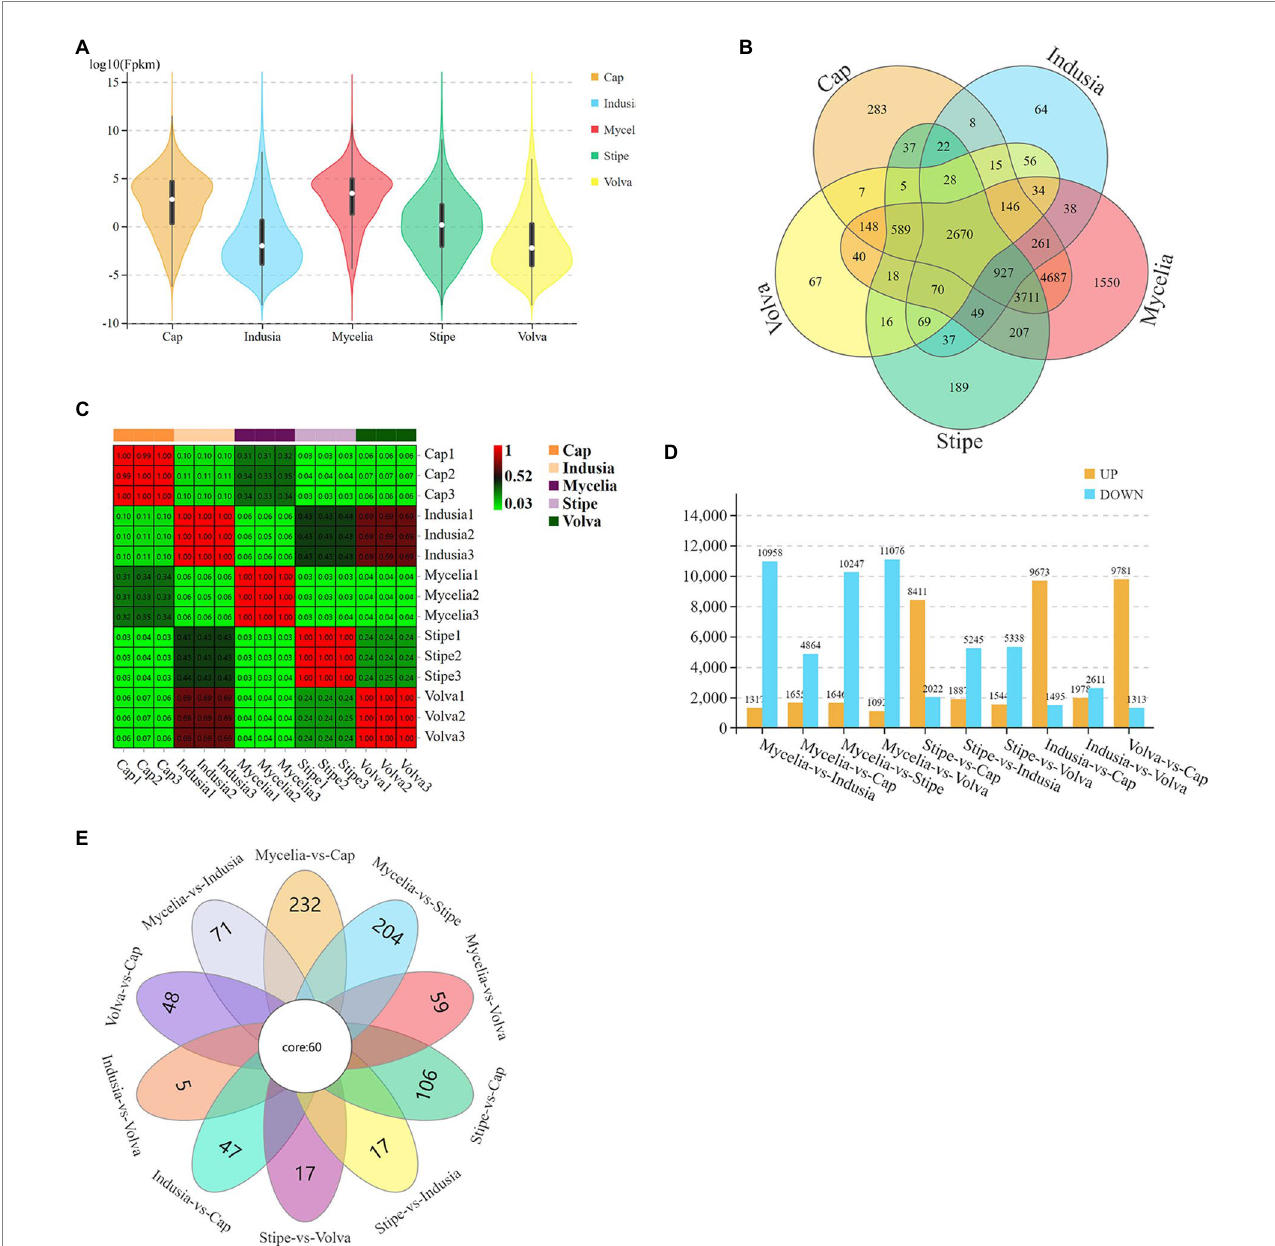
FIGURE 3 Distribution of DEGs across different DI tissues. (A) The violin plots display the gene expression intensity in five tissue types of DI. The curves represent the probability curve of the data distribution. The number of data points is positively correlated with the width of the probability curve. The upper and lower ends indicate the maximum and minimum values of nonoutliers, respectively. The upper and lower edges of the vertical line indicate the 75 th and 25 th percentiles of the data, respectively; the central dot indicates the median. The horizontal axis represents different tissues, and the vertical axis represents the log 10 FPKM. (B) Venn diagram of DEGs in five tissues. Different colors represent different tissues. (C) Correlation heat map based on the expression of DEGs in five tissues. The abscissa and ordinate indicate the samples. The numbers in the grid are the Pearson correlation coefficient values. The different colors of the grid indicate different correlations. Red means a positive correlation; the darker the color, the stronger the correlation. (D) DEGs of each comparison group. The abscissa represents different comparison groups, and the ordinate represents the number of DEGs. (E) Venn diagram of DEGs of different comparison